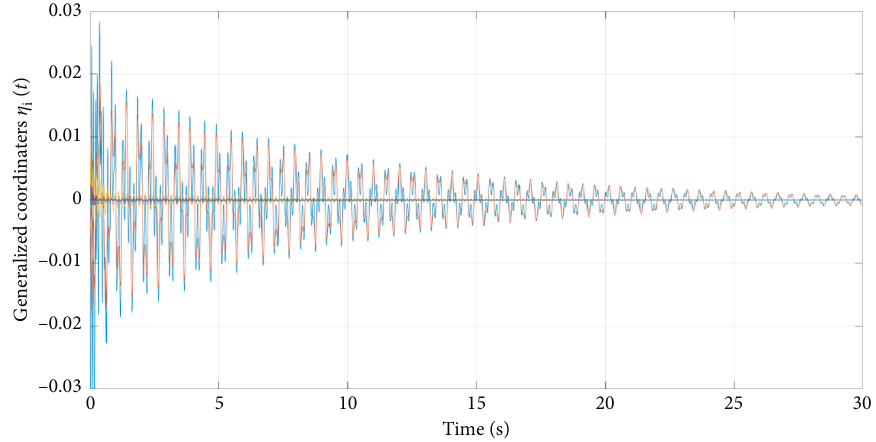
Figure 3: Generalized coordinates η